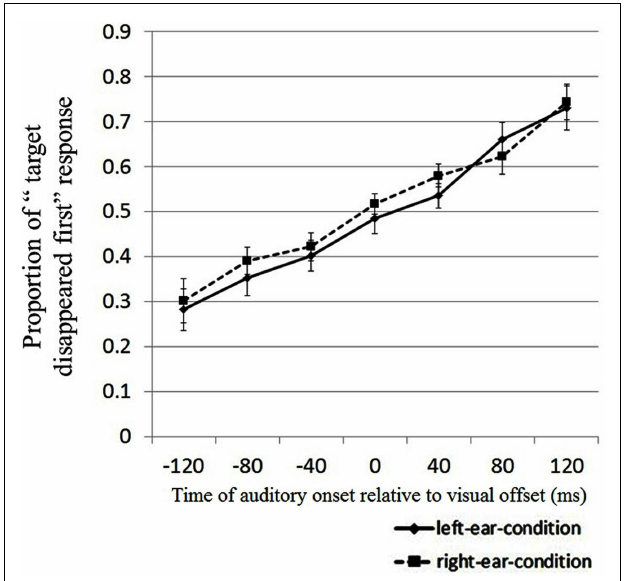
FIGURE 4 | Results of Experiment 3. The horizontal and vertical axes represent the different sound presentation conditions and the proportion of “target disappeared first” responses, respectively. Error bars represent within-participants SEMs (Loftus and Masson, 1994; Cousineau, 2005) for each